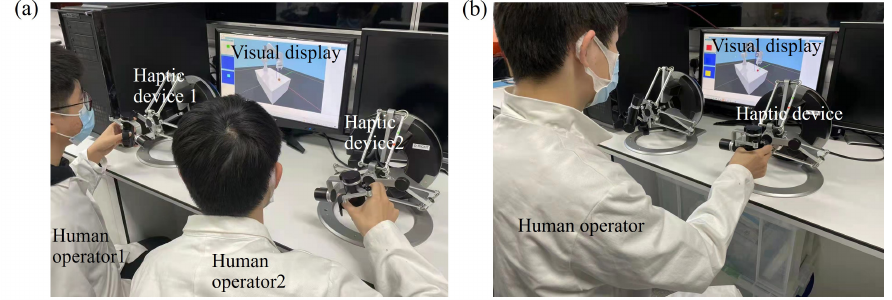
Figure 9. Experiment setup in ( a ) human–human cooperation mode and ( b ) human–agent coopera- tion